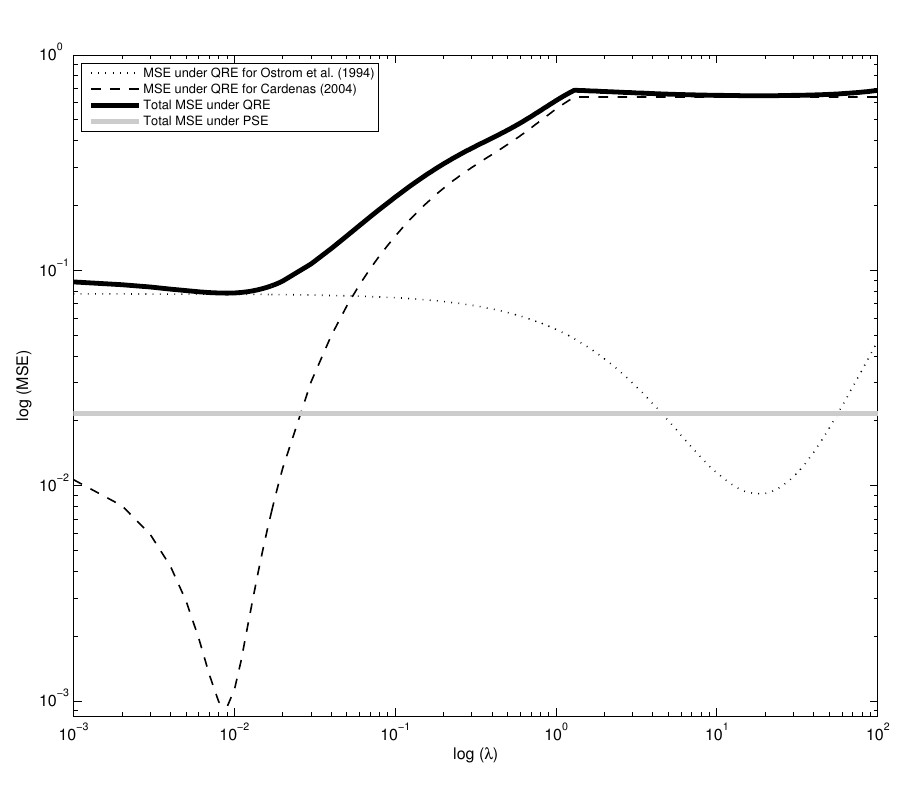
Figure 3. Aggregated mean squared errors as a function of λ